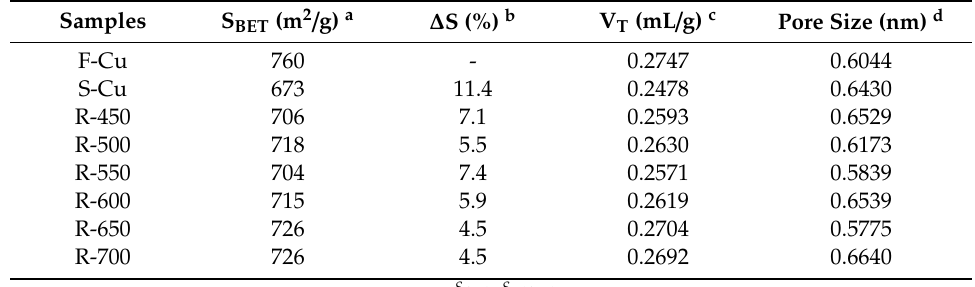
Table 1. Textural properties over Cu-SSZ-13 catalysts in fresh, sulfated and regenerated states.